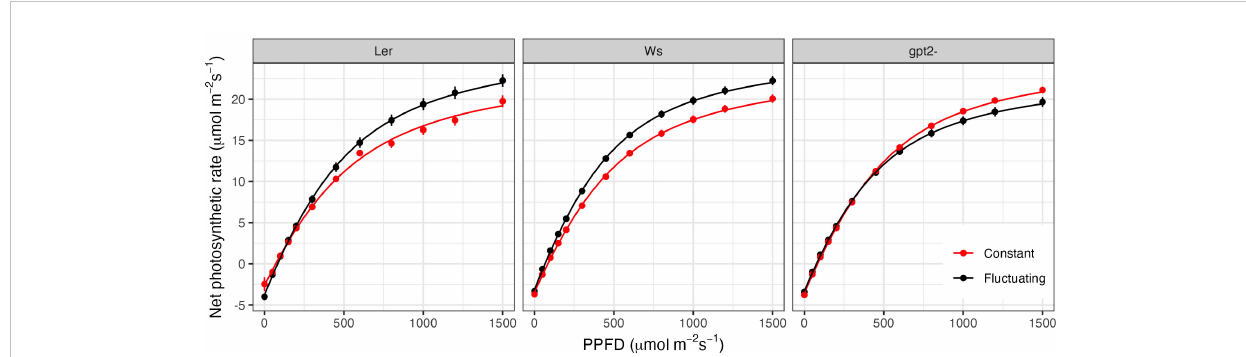
FIGURE 3 Light response curves for plants grown under constant light (red) versus fl uctuating light (black). Light response curves were measured 35 days after sowing, equivalent to 9 days after starting the fl uctuating light pattern (FL plants).